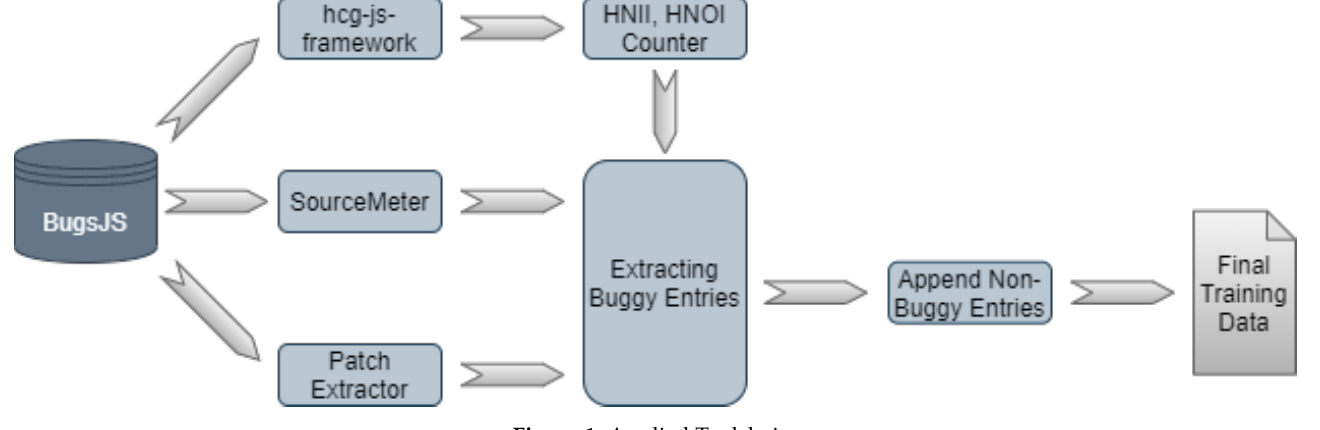
Figure 1. Applied